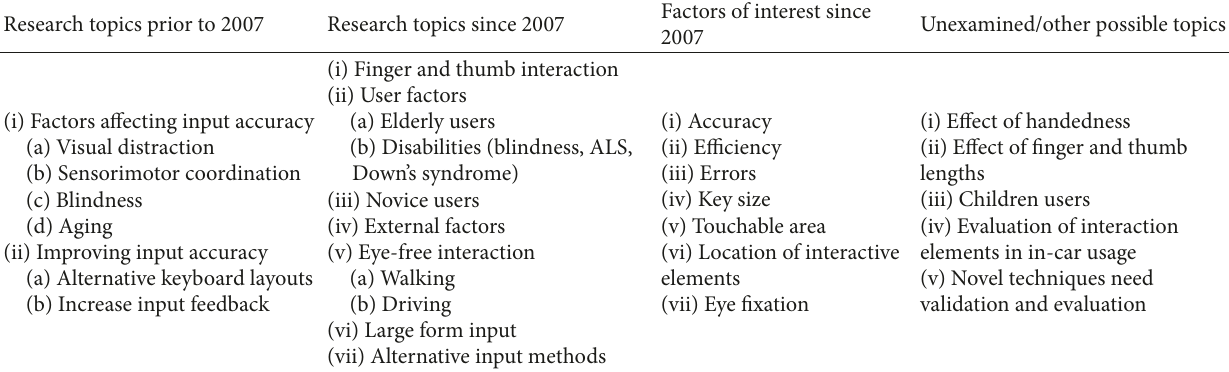
Table 13: Input Mode and Selection